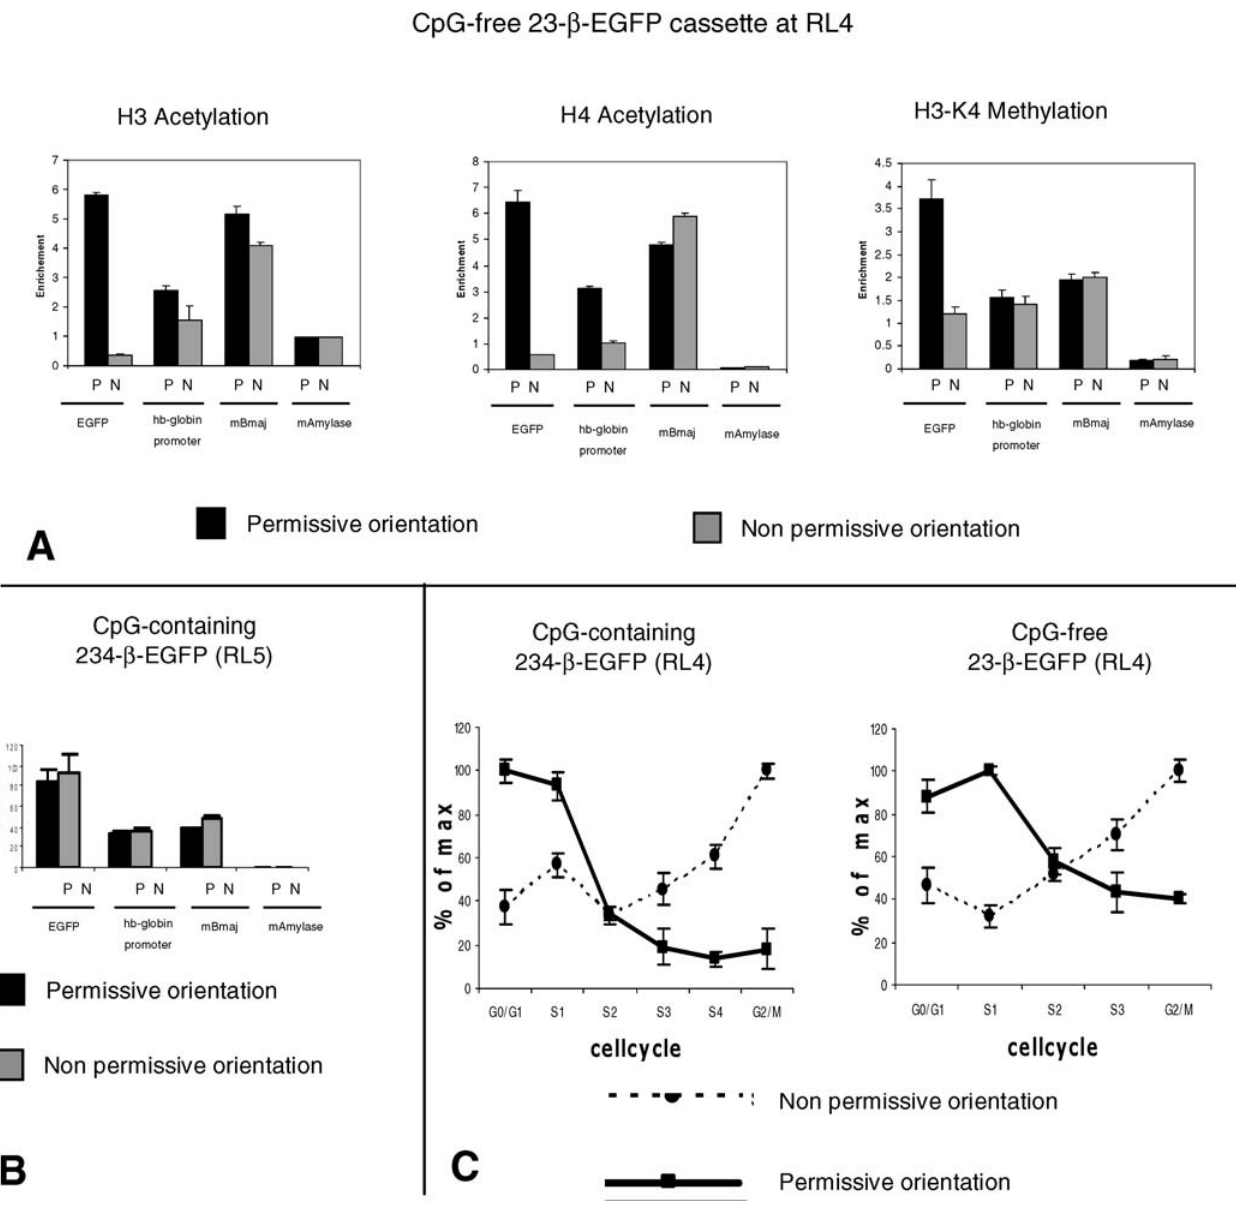
Figure 2. CpG-Free Silencing Is Associated with Lack of Acetylation of H3 and H4, Lack of Methylation of H3-K4, and Replication in Late S Phase (A) Histone modification analysis by ChIP assays. The histograms summarize the results of quantitative PCR measurements of abundance of the EGFP coding sequence, the h b -globin promoter, the mouse b -major promoter region (mBmaj), and a fragment of the mouse amylase coding sequence (mAmylase) in chromatin from cells containing cassette 23- b -EGFP at RL4 precipitated with polyclonal antibodies against acetylated H3-tails (left), acetylated H4-tails (middle), and methylated H3-K4-tails. The enrichment of specific sequences in modified chromatin compared to total chromatin was calculated as described in Materials and Methods. Both the EGFP coding sequence and the b -globin promoter of the CpG-free 23- b -EGFP cassette are enriched when acetylated on H3 and H4 and H3-K4 methylation and when they are in the P orientation, but not when they are in the N orientation. (B) ChIP analysis of the CpG-containing cassette inserted at RL5 in the N or P orientation. The two orientations are similar, and, as at RL4, the enrichment is higher for the EGFP coding sequences than for the promoter. (C) Timing of replication analysis: The histograms summarize the results of quantitative PCR measurements of the abundance of the CpG-free and CpG- containing EGFP coding sequence in FACS-separated, BrdU-immunoprecipitated newly replicated DNA fragments from cells containing the CpG- containing (left) or the CpG-free (right) LCR- b -EGFP cassettes. Both cassettes replicate early when they are in the P orientation and late when they are in the N orientation. Controls were as in Figure 3. N, non-permissive orientation; P, permissive orientation. DOI: 10.1371/journal.pgen.0020065.g002